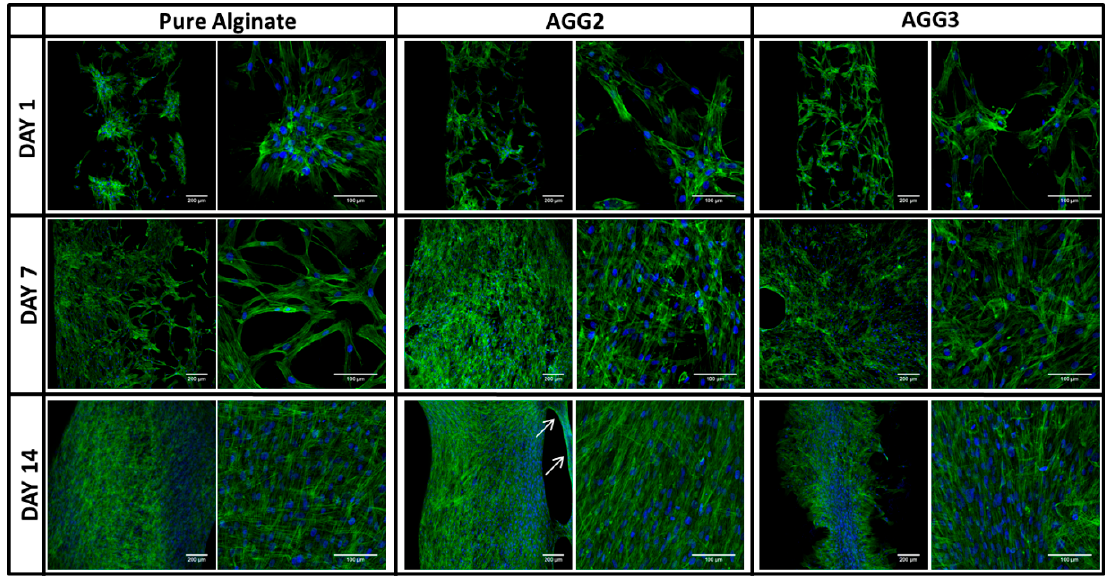
Figure 8. cLSM images of osteogenically uninduced hMSC cultured on scaffolds for 14 days. (blue: nucleus stained with Hoechst, green: actin cytoskeleton stained with phalloidin-AlexaFluor 488; arrows: cell sheets).